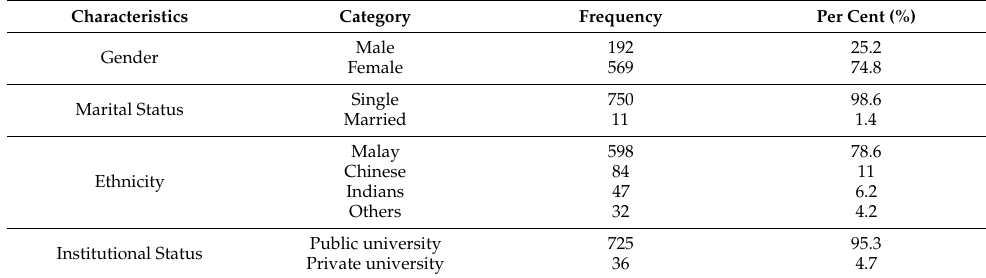
Table 2. Demographic Profile of Respondents.